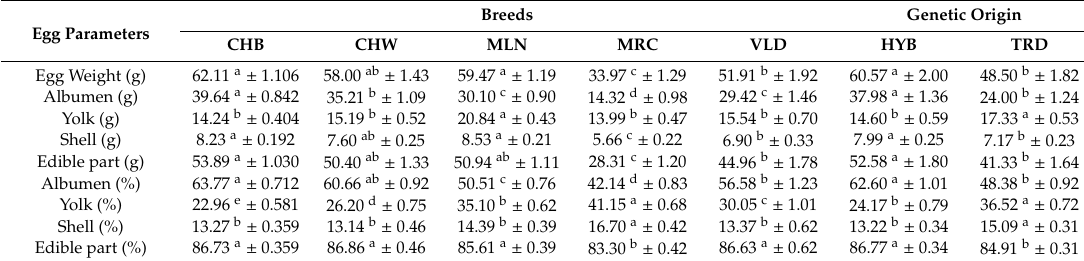
Table 2. Physical egg parameters (LS mean ± SE) by